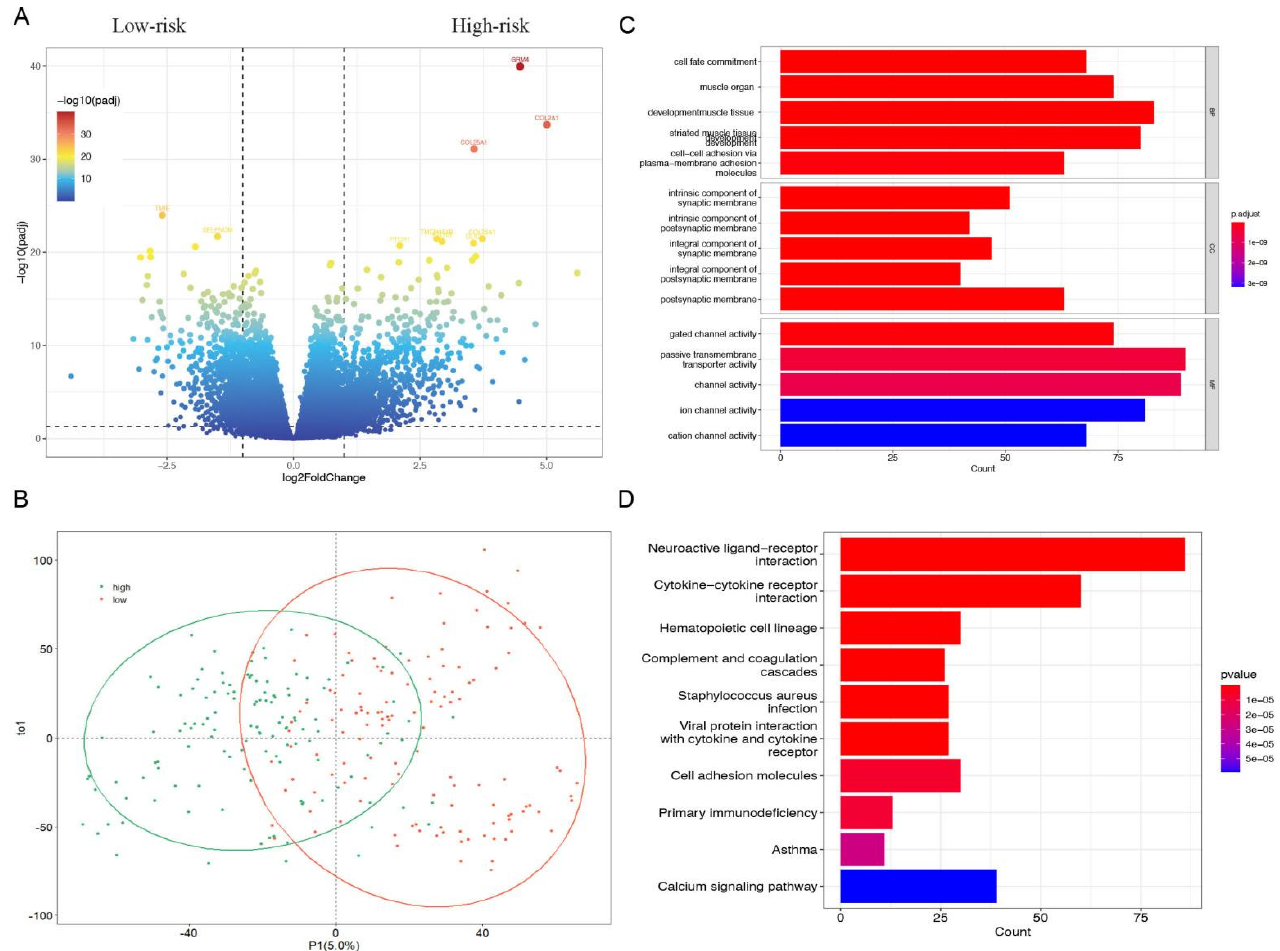
Figure 4. Exploring of DEGs of high- and low-risk groups in patients with sarcoma. ( A ) The result of a volcano plot. The dots on the right site indicated the high-risk genes, the dot on the left site is the low-risk genes, and the in-between dots indicated the other genes without significant difference.